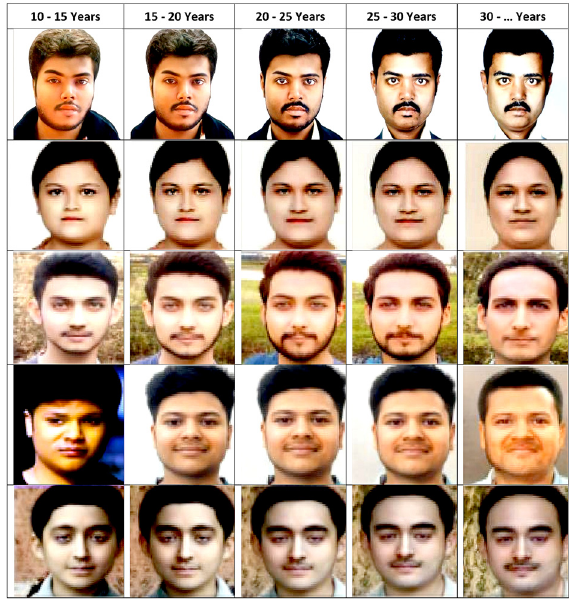
Figure 7. Model trained on F1L2M8 tested on selected real existing persons.